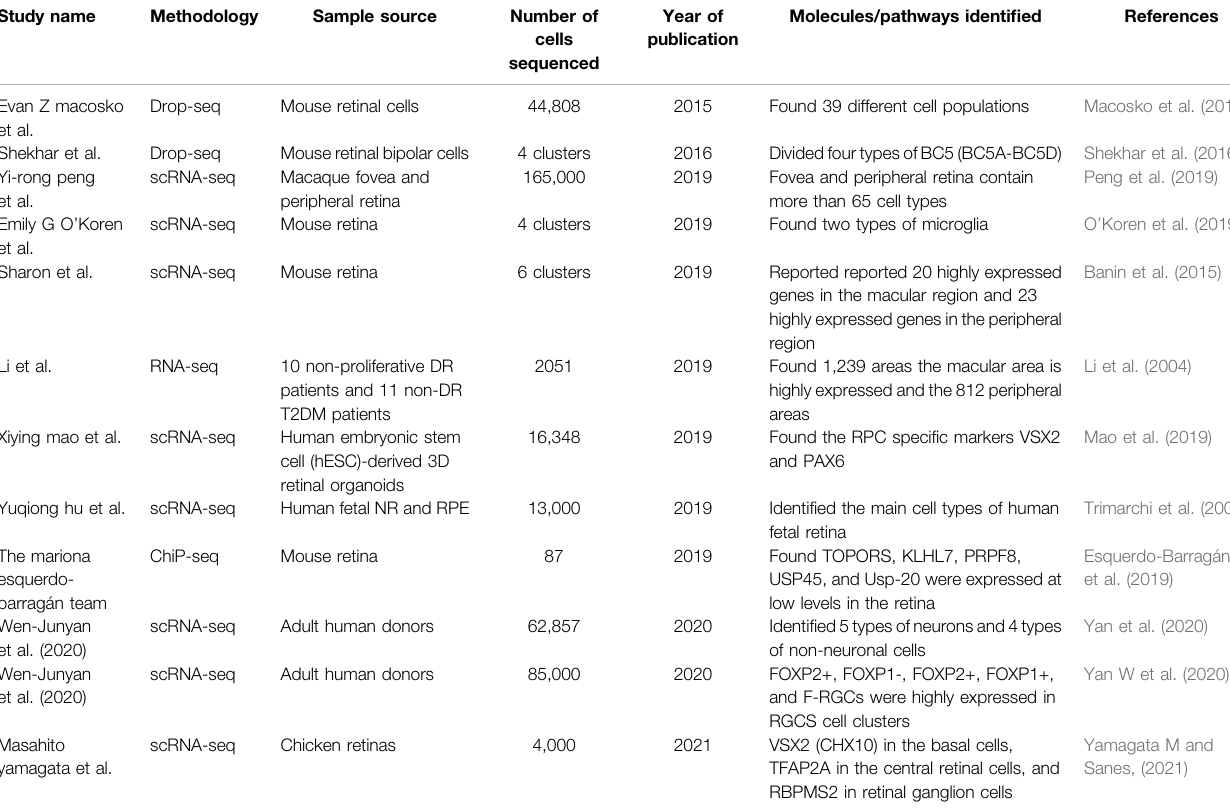
TABLE 2 | New discoveries of genes and cell subtypes related to